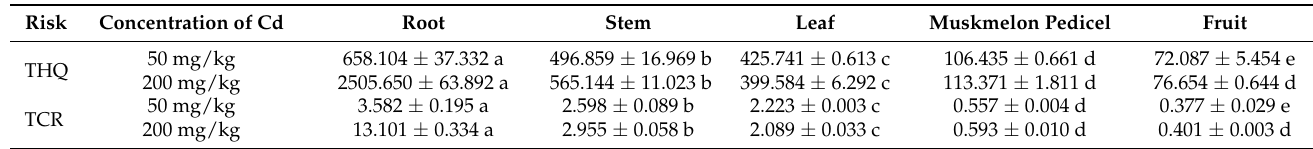
Table 2. Health risk assessment of different parts treated with different concentrations of Cd. Each treatment was repeated three times, expressed as mean ± standard deviation. Each line of different letters represents significant differences at p <